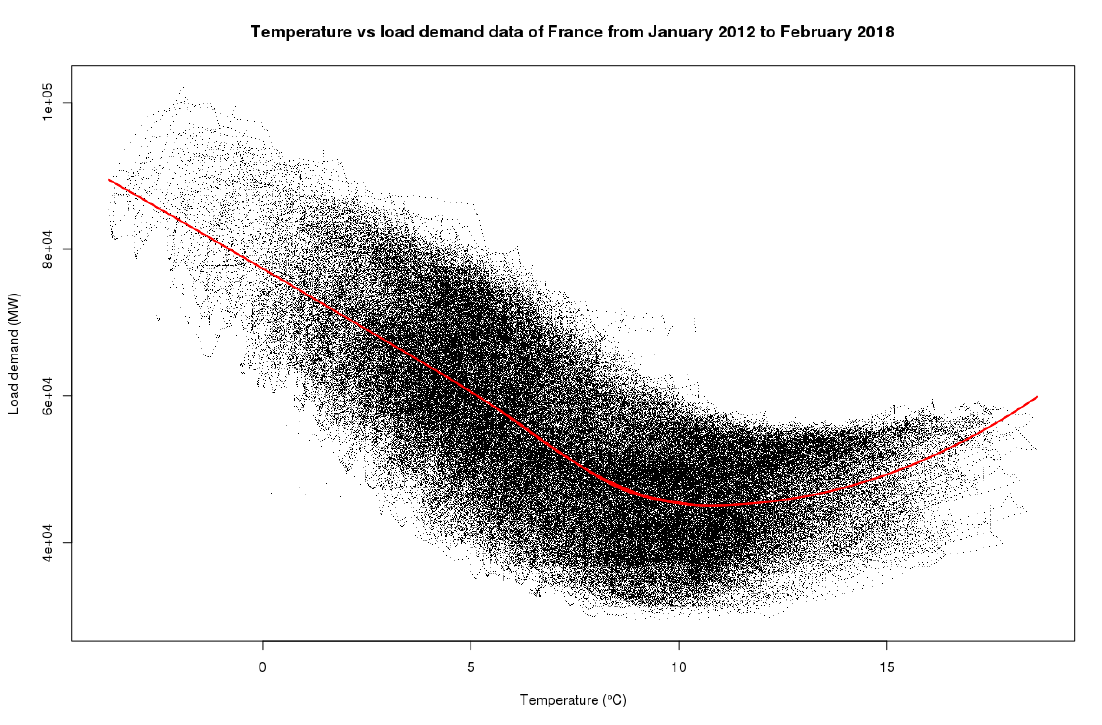
Figure 10. Daily load demand for France’s electricity grid versus temperature in France from January 2012 to February